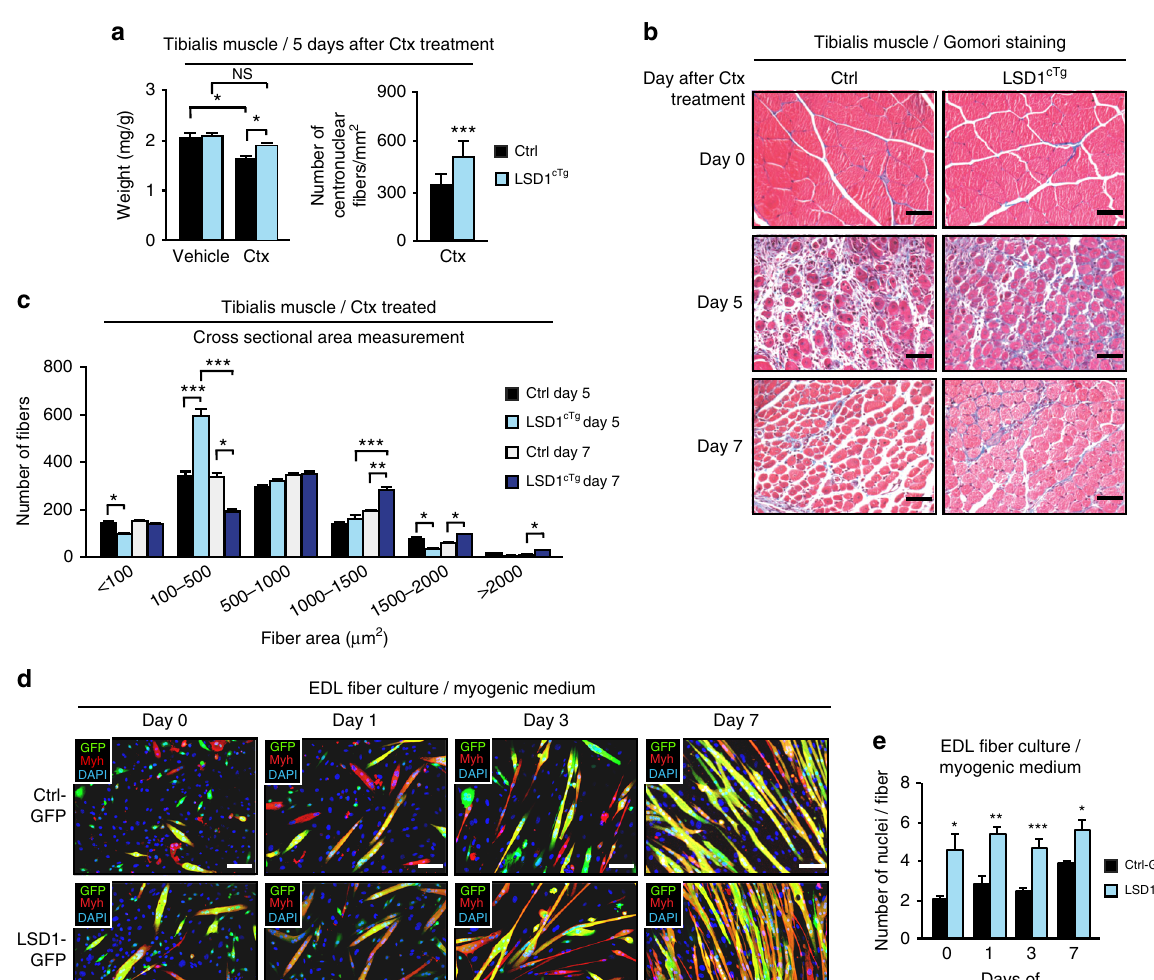
Fig. 2 Lsd1 overexpression accelerates skeletal muscle regeneration. a Tibialis muscle mass normalized to body mass of control mice (Ctrl) or mice overexpressing LSD1 selectively in Myf5-positive muscle precursors (LSD1 cTg ) 5 days after Ctx or vehicle injection (left panel). Number of regenerating centronuclear fi bers per area (mm 2 ) in Ctrl and LSD1 cTg mice 5 days after Ctx treatment (right panel). Signi fi cance was calculated by two-way ANOVA test. b Gomori staining of representative tibialis muscle sections from Ctrl and LSD1 cTg mice 0, 5, and 7 days after Ctx treatment. c CSA measurement of regenerating centronuclear muscle fi bers from Ctrl and LSD1 cTg mice 5 and 7 days after Ctx treatment. Signi fi cance was calculated by two-way ANOVA test. d Immuno fl uorescence assay using antibodies directed against pan-myosin heavy chain (Myh, red) and green fl uorescent protein (GFP, green) on control (Ctrl-GFP) and LSD1 overexpressing (LSD1-GFP) satellite cells isolated from extensor digitorum longus (EDL) fi ber culture differentiated in myogenic medium for 0, 1, 3, or 7 days. Nuclei were stained with DAPI (blue). e Quanti fi cation of the nuclei per fi ber shown in immuno fl uorescence assay in d . Signi fi cance was calculated by two-tailed Student ’ s t -test. ( a , c : n = 5, e : n = 3; mean + SEM, NS = non-signi fi cant, * p < 0.05, ** p < 0.01, *** p < 0.001; scale bars: b , d 100 µ